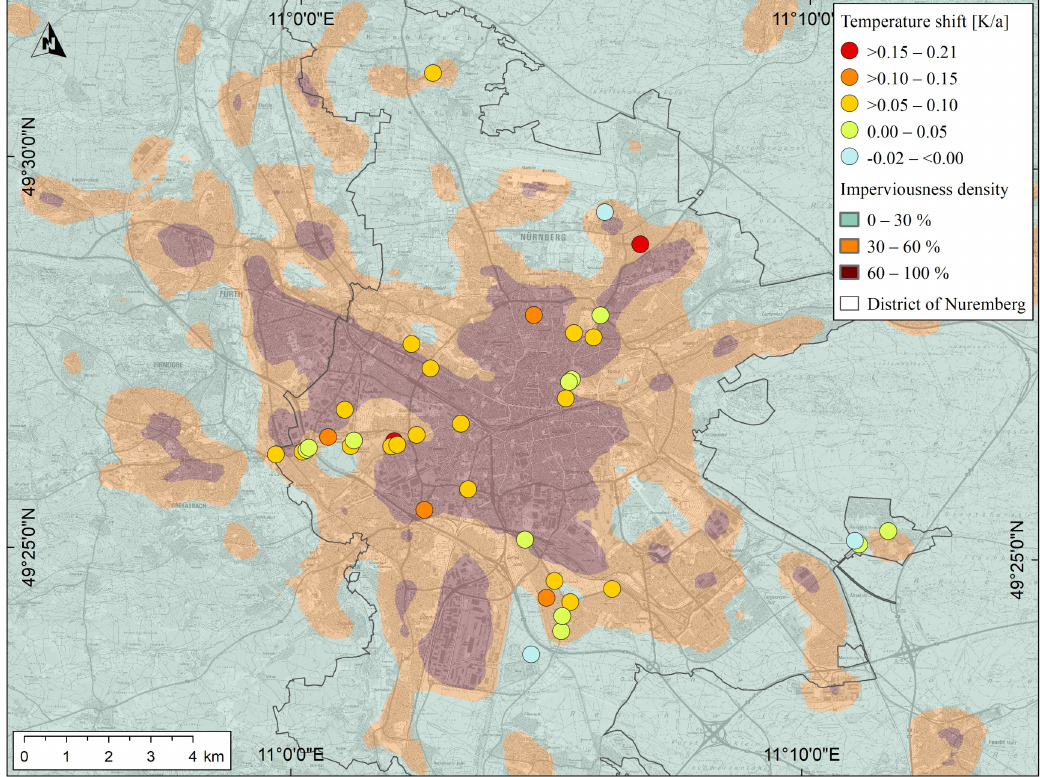
Figure 6. The map shows IMDr = 500 categorized into three classes: class 1 in green ranges from 0–30%, class 2 in orange contains IMD values 30–60%, and class 3 is the highly sealed, inner-city area, shown in red, with values from 60–100%. In addition, the monitoring wells are shown with their mean annual changes in groundwater temperature from 2015 to